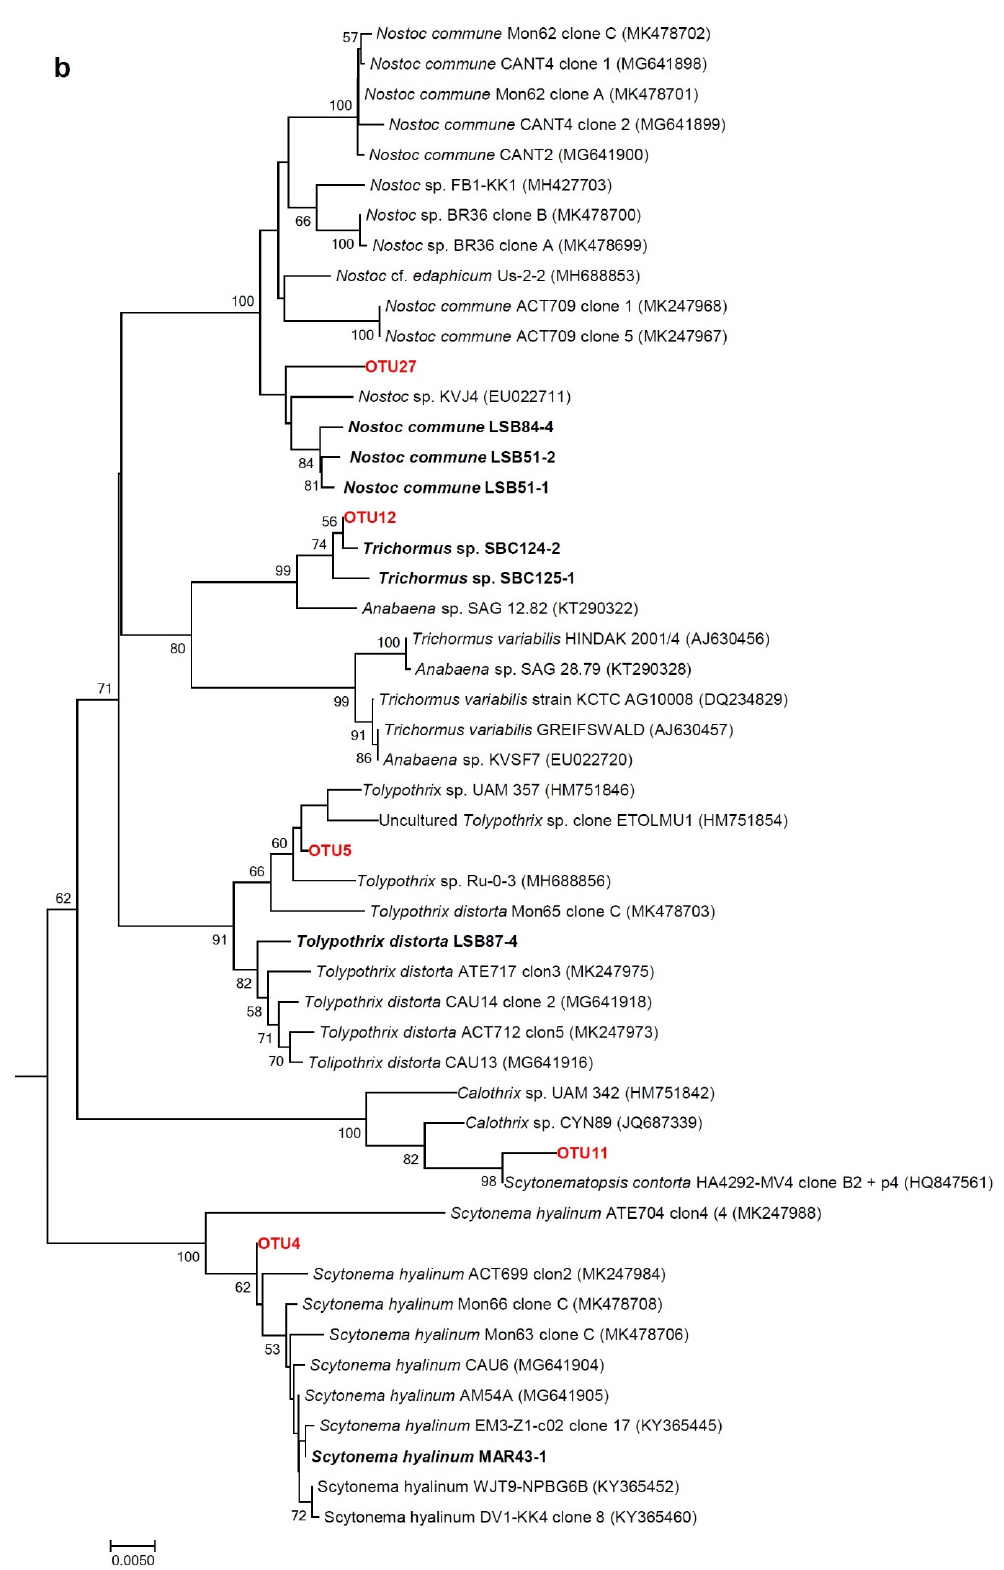
Figure 6. ( a ) Phylogenetic tree obtained by the neighbor-joining method based on the analysis of 16S rRNA gene, showing the position of the sequences of the isolated strains obtained in the present study (in bold) and the Operational Taxonomic Units (OTUs) determined by amplicon metagenomics (in red). ( b ) heterocystous cyanobacteria expanded. Numbers near node indicate bootstrap values greater than or equal to